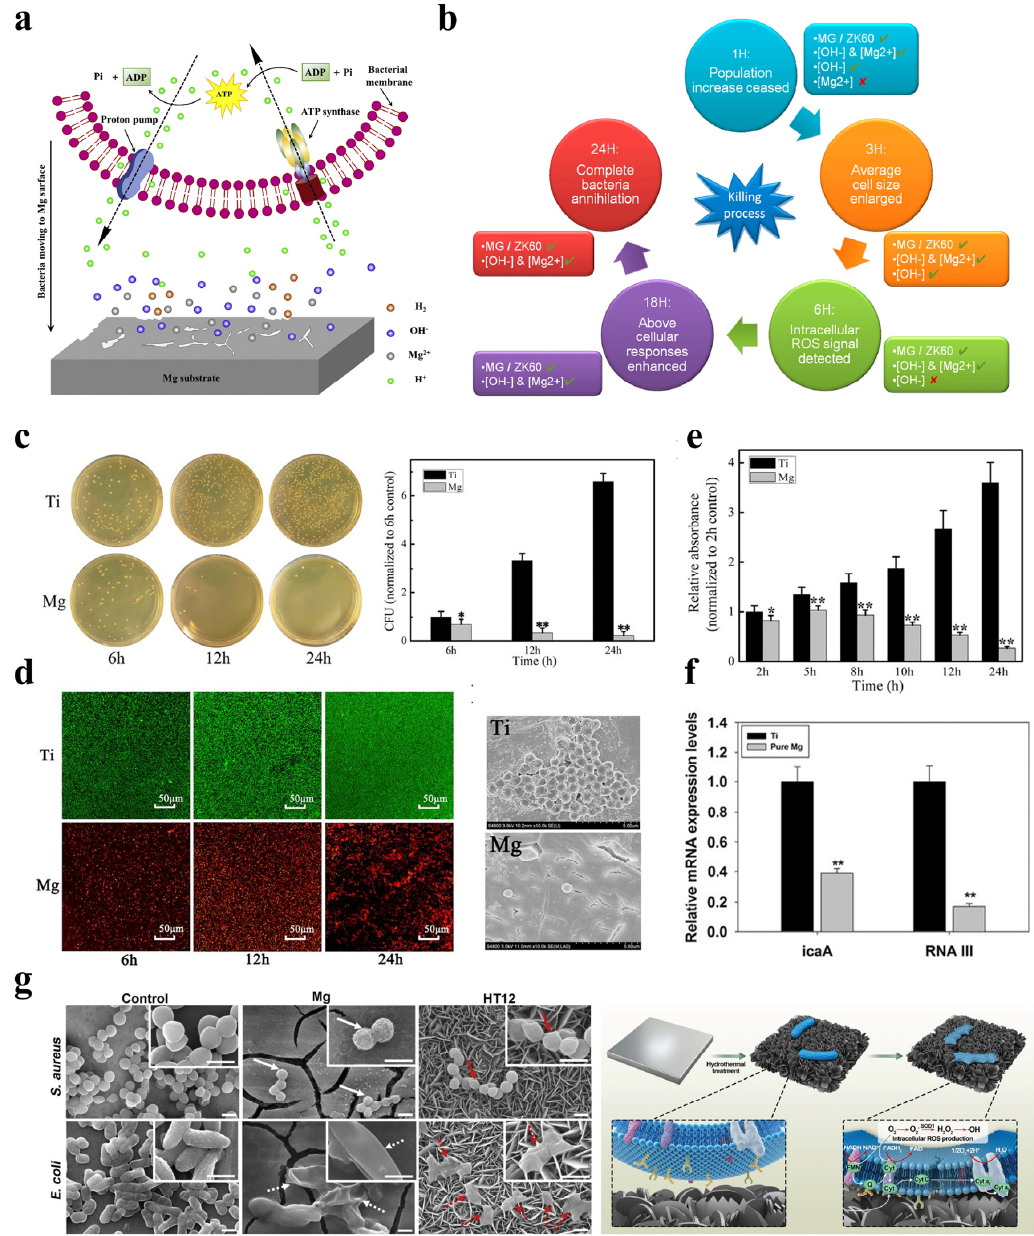
Figure 7. The antibacterial behavior of Mg-based alloys. ( a ) A possible antibacterial mechanism of Mg-based alloys due to the generation of hydroxyl ions on surface. Reproduced with permission from [117]. Copyright 2020, Elsevier. ( b ) A diagram illustrating the bacterial killing process and cellular response of Mg-based alloys during 24 h. Reproduced with permission from [131]. Copyright 2016, American Chemical Society. ( c ) Representative images displaying viable bacteria adhered on samples after 24 h culture and normalized number of bacteria. ( d ) Fluorescent and SEM images illustrating the viable or dead bacteria adhered on the sample surface after 24 h culture. ( e ) the anti-biofilm ability of Mg and Ti tested by crystal violet staining method. ( f ) Expressions of the icaA and agr RNAIII genes derived from RT-PCR tests. * p < 0.05, ** p < 0.01. Reproduced with permission from [121]. Copyright 2014, American Society for Microbiology. ( g ) Morphology of S. aureus and E. coli cultivated on Ti-, Mg-, and HT12-treated samples for 3h and the antibacterial mechanism of surface Mg(OH) 2 . Scale bars: 1 µ m. Reproduced with permission from [130]. Copyright 2014, Wiley-VCH